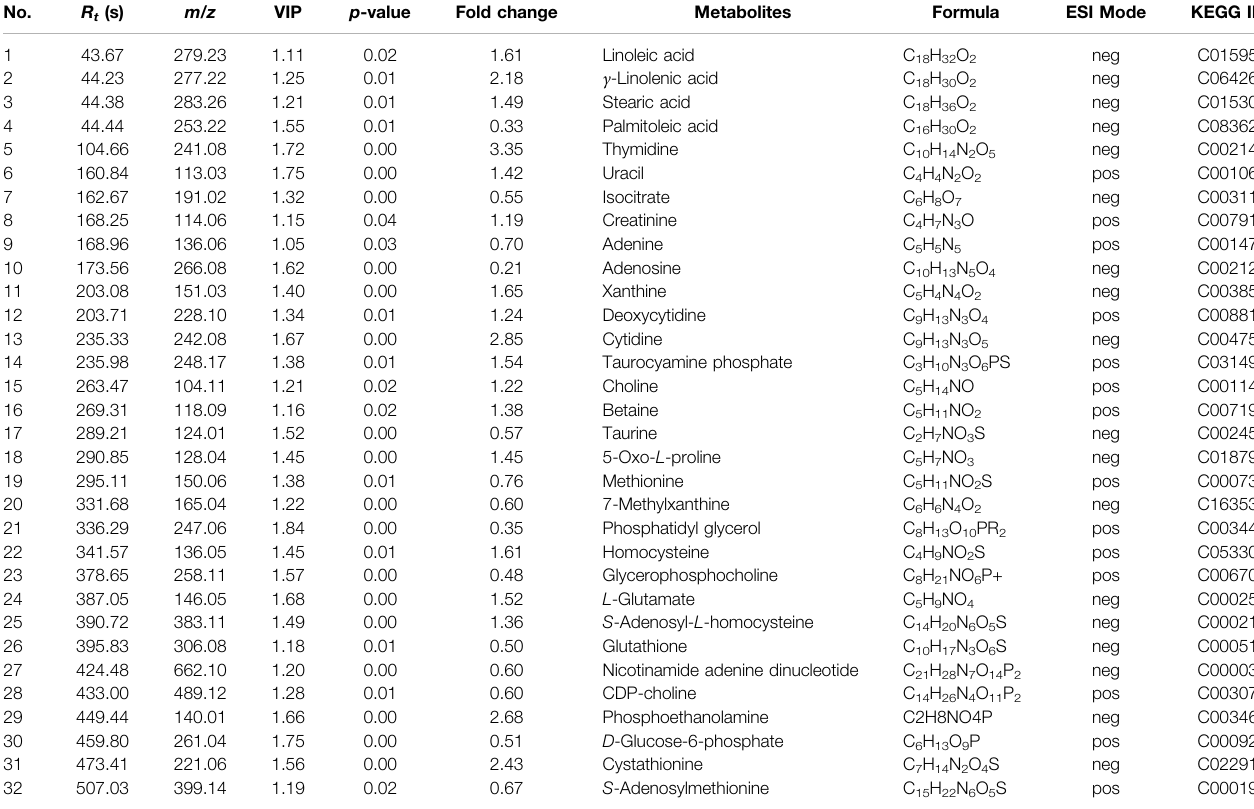
TABLE 1 | Differential metabolites between the normal and model groups.